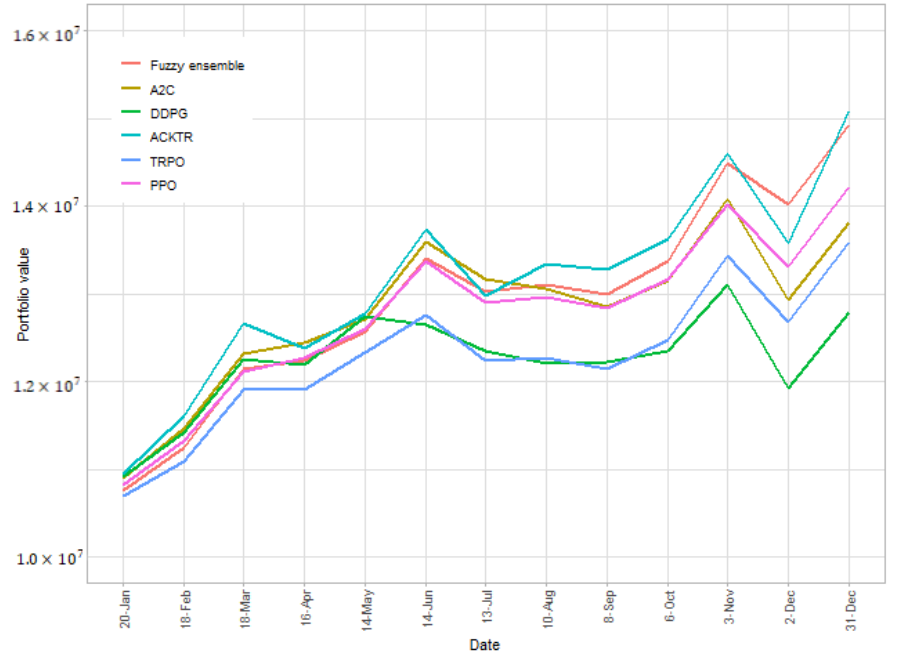
Figure 7. Time series plot for the portfolio value of our fuzzy ensemble model compared to other RL algorithms with a starting amount of 10,000,000